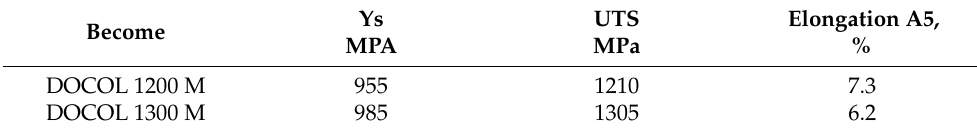
Table 4. DOCOL 1400M steel and its mechanical properties (own research).